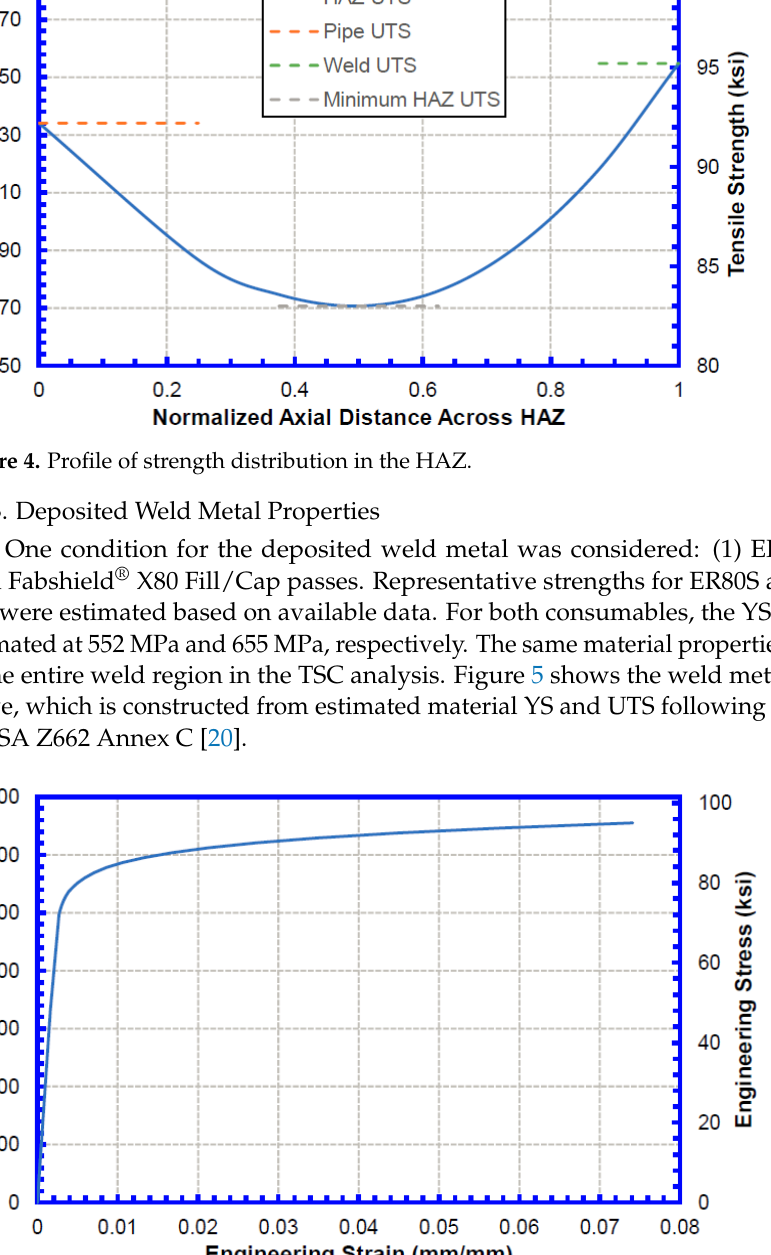
Figure 4. Profile of strength distribution in the HAZ.